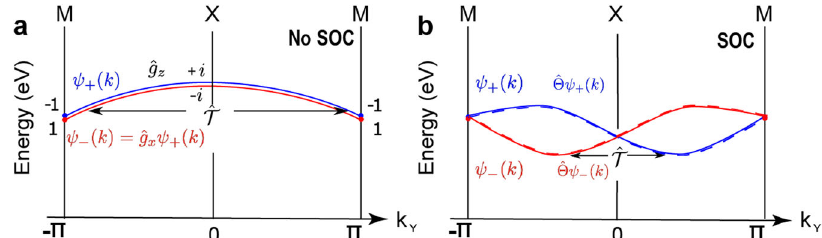
Fig. 3 Nonsymmorphic symmetry-protected band degeneracy. a Without SOC, glide symmetries ^ g ^ g ψ . Here the blue and red solid lines denote the two bands with ± ^ g two bands ψ + and ψ x (cid:2) ¼ þ bands become symmetric with respect to k y = 0 under time-reversal symmetry ( each of them becomes doubly degenerate due to Kramer ’ s pairing. The presence of both time-reversal the fourfold band crossings at k y = 0, ± π ( X and M ).